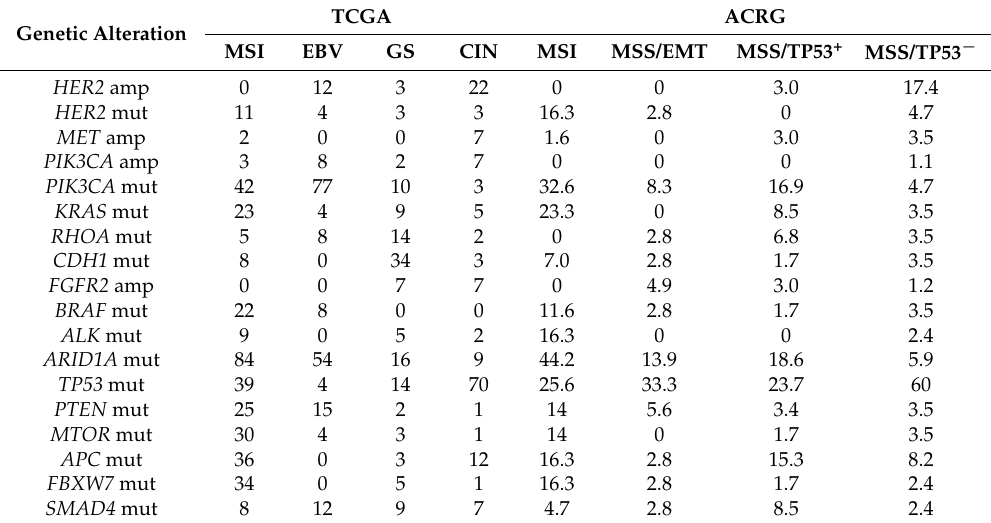
Table 3. Distribution of key genomic alterations across molecular subtypes of gastric carcinoma from TCGA and ACRG